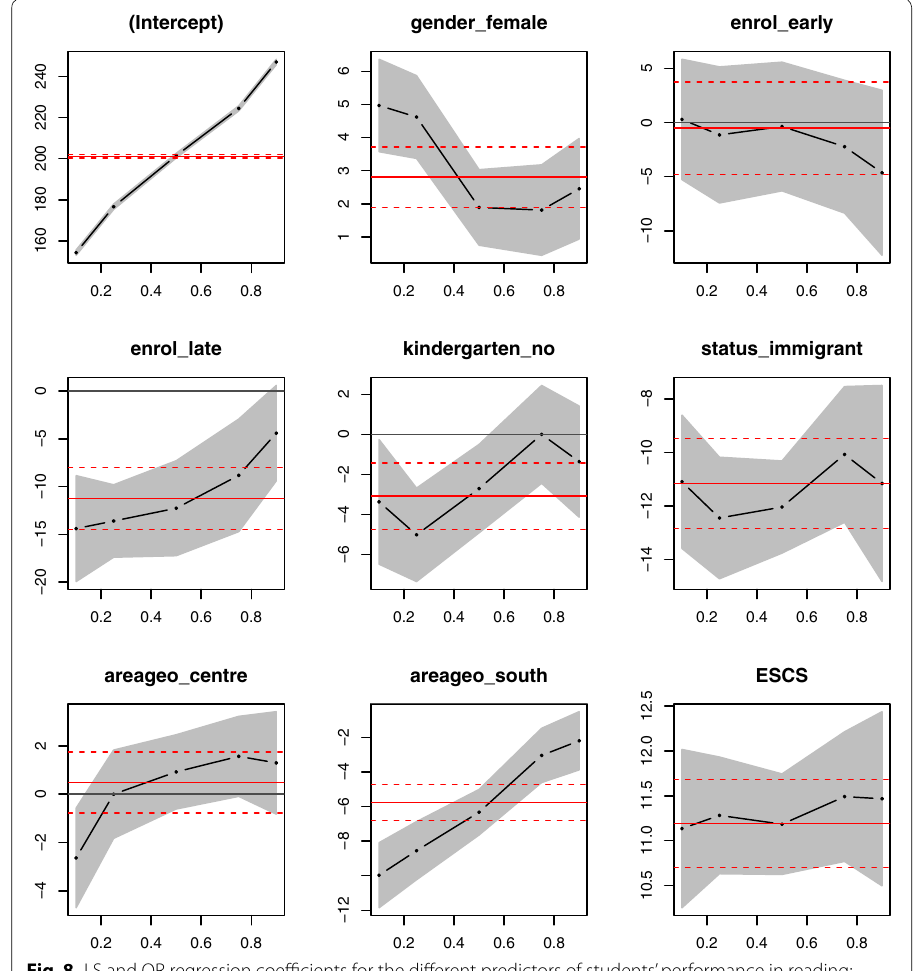
Fig. 8 LS and QR regression coefficients for the different predictors of students’ performance in reading: fifth-graders